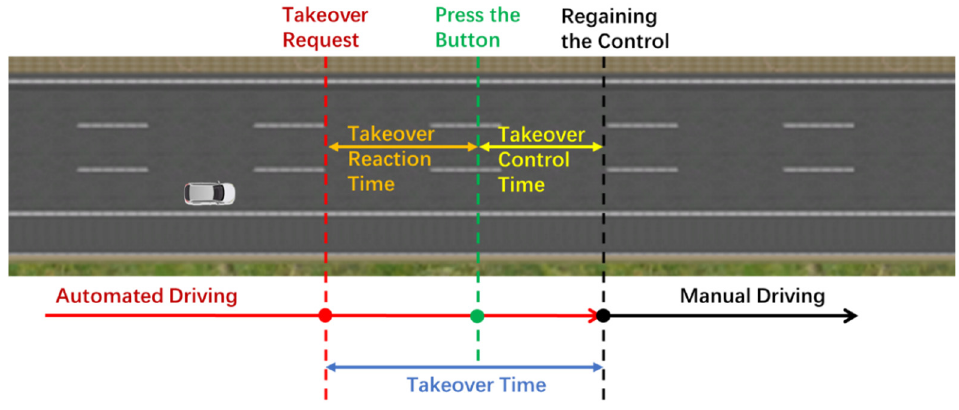
Figure 4. The takeover procedure and defines of takeover-related